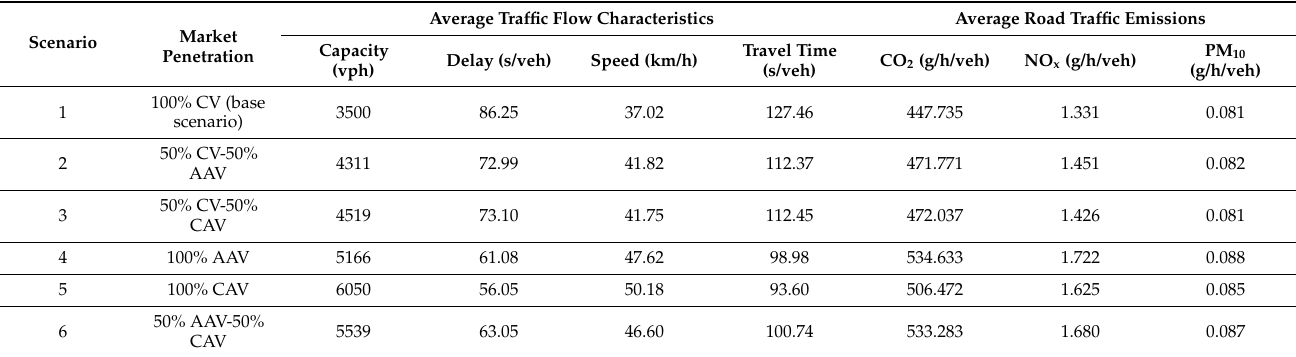
Table 4. Traffic flow characteristics and traffic emissions for a diverging segment.